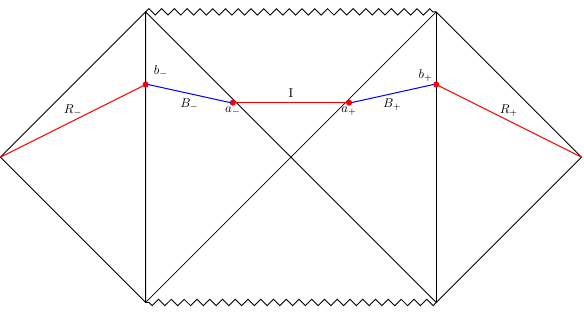
Fig. 1 Penrose diagram of eternal BTZ black hole + flat auxiliary thermal bath system specifying regions for the computation of cor- responding von Neumann entropies. We denote a ± = ( ± t a , a ) and b ± = ( ± t b , b